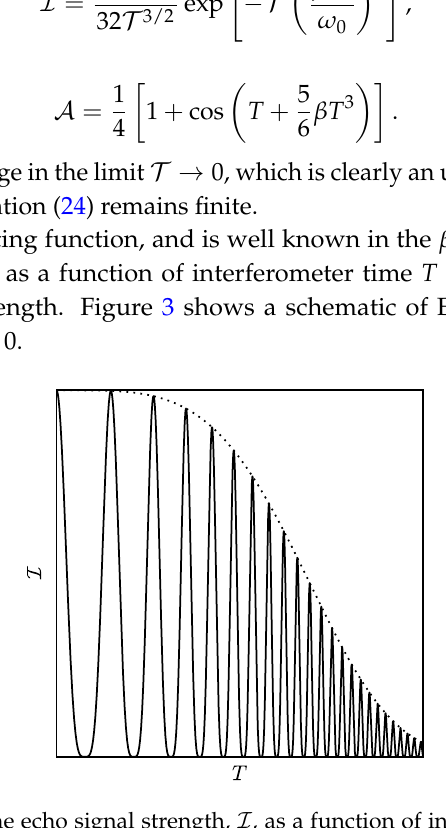
Figure 2. A schematic of the echo signal strength, I , as a function of interferometer time, T , for an interferometer in a positive residual trapping potential, i.e., β > 0. The signal strength is proportional to the total number of backscattered photons during the readout laser pulse. I is periodic with an increasing frequency within an envelope defined by the dotted curve.